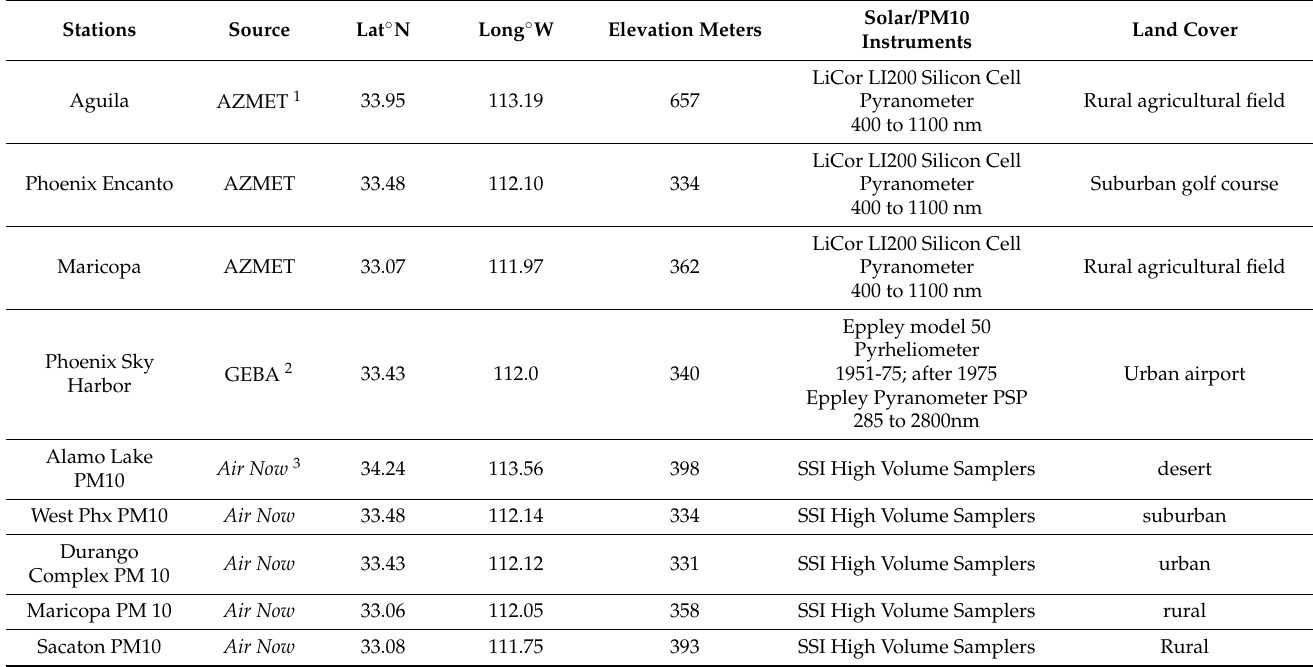
Figure 1. Study area of Phoenix, AZ in the desert SW USA. Sites used are shown with symbols and legend refers to the type of site, all mentioned in the paper. The orange pattern shows the urbanized area. Upper left corner of map = 34.38°N, 113.93°W; lower right = 32.76°N, 110.95°W. Table 1. Sites used in the study. See Figure 1 for the locations.